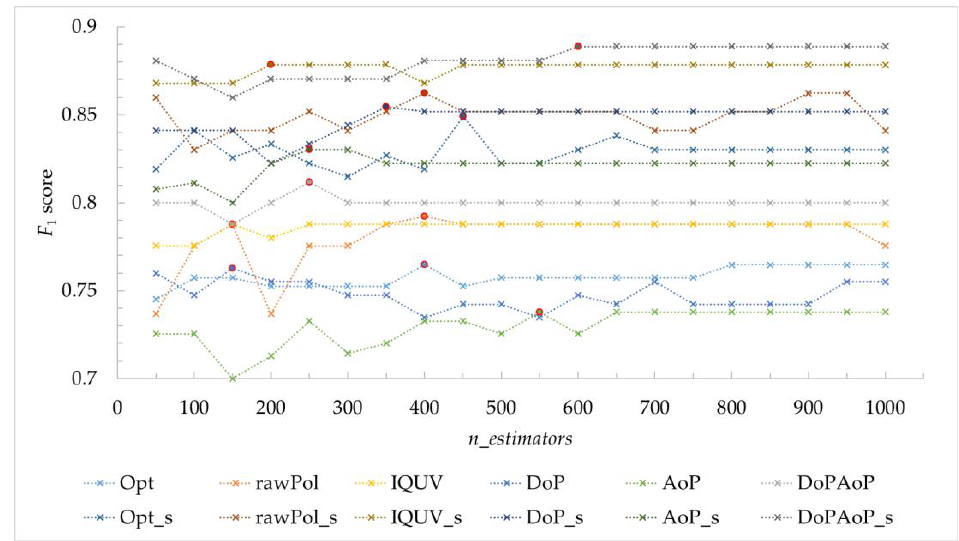
Figure 5. Determining the model parameter n_estimators by F 1 score.